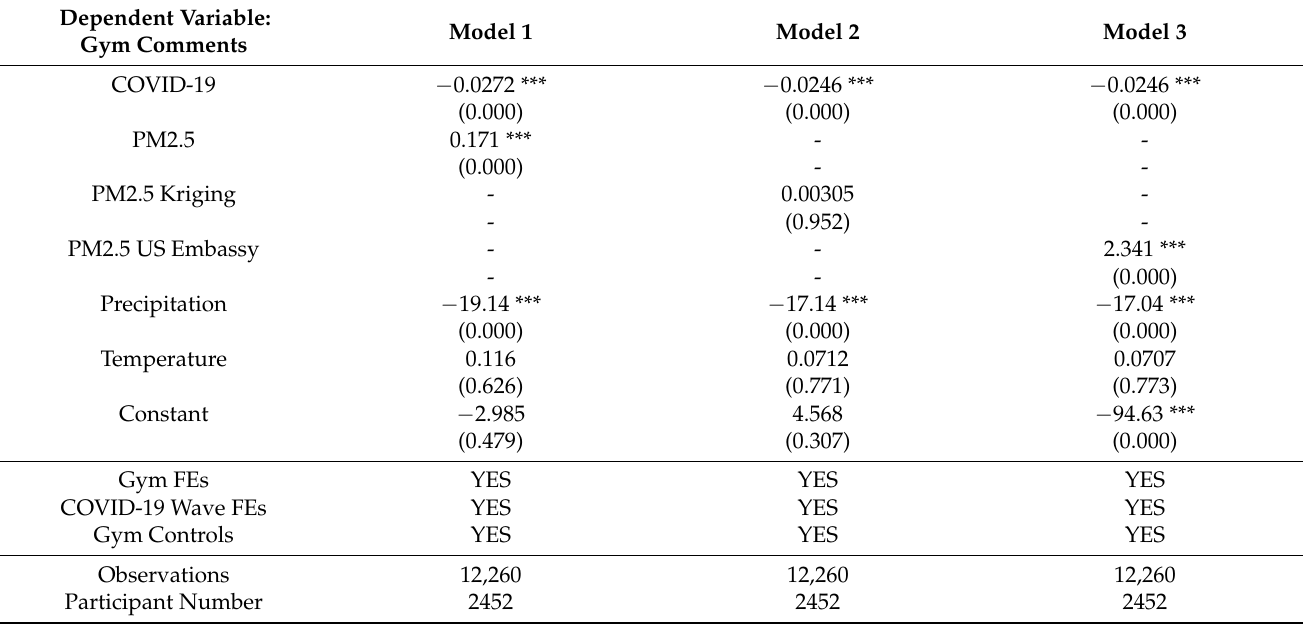
Table 5. Estimated associations between PM2.5 and gym visits in